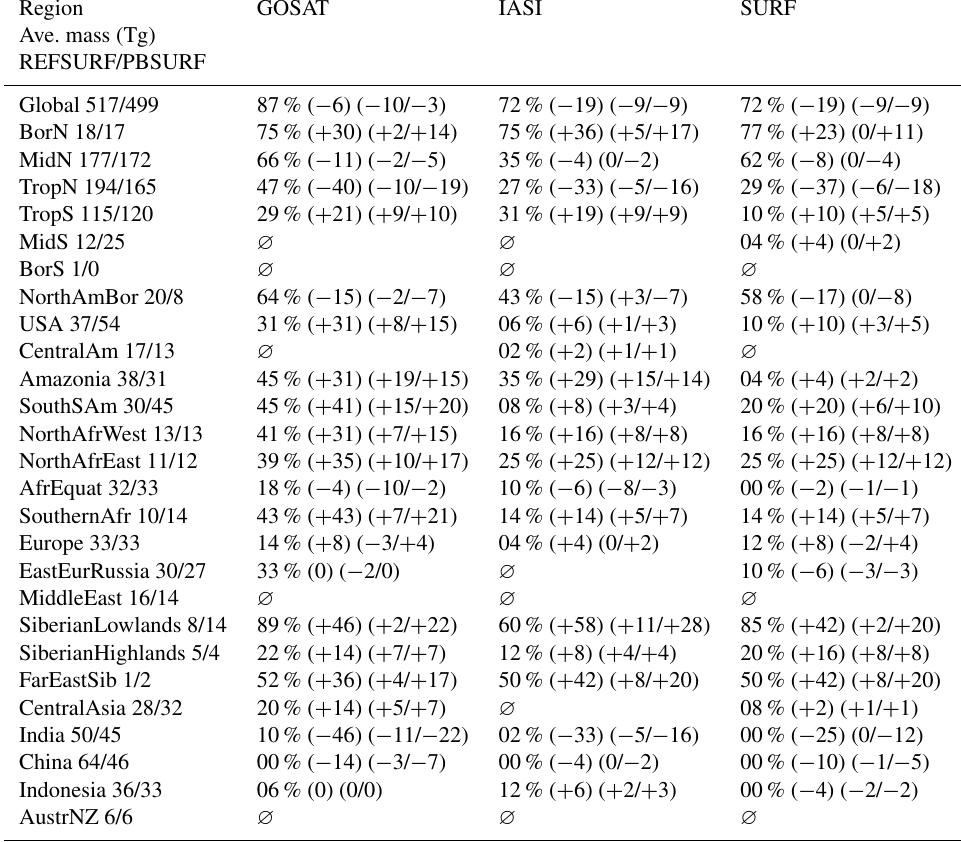
Table A2. Detection of the signal consisting in the anomalies at the seasonal timescale (JFM, AMJ, JAS, OND). The signal is the difference between each quarter in the 2000–2011 period (i.e., 48 occurrences) and the 2004–2005 average from PBSURF. The noise is computed at the quarter timescale from each of the three observation systems, GOSAT, IASI and SURF. See Sects. 2.4 and 2.3 for details. In each cell of the table, we show X % ( ± T T ) ( ± YY/ ± ZZ ) where X % is the percentage of quarterly anomalies detected, ( ± T T ) is the difference with REFSURF (Table 1), ± YY is the difference in the number of positive anomalies detected compared to REFSURF and ± ZZ is the difference in the total number of detected anomalies compared to REFSURF. Ave. mass indicates average emitted mass of CH 4 over